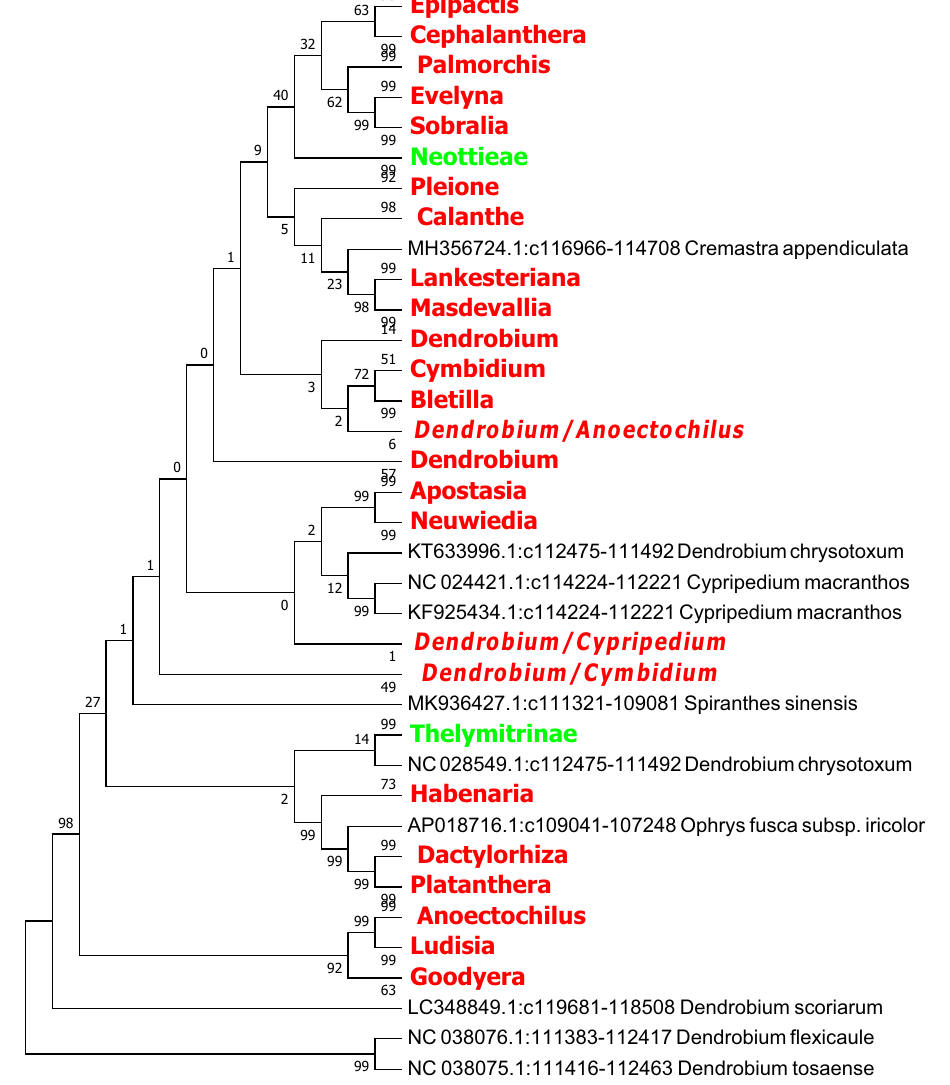
Figure 4. The NJ tree of Orchidaceae coming from analysis of the cp DNA ndhF sequence based on the K2P model. Names tagged in red indicates the genus and tagged in green showed the subtribe; The Numbers on the branches represent more than or equal to 50 percent support after the 1000 bootstrap replications test; Numbers following taxon names showed the number of